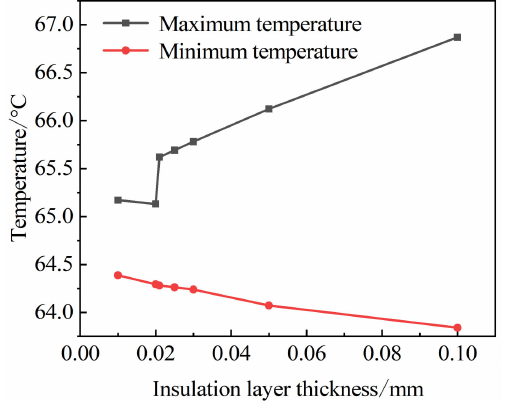
Figure 4. LED temperature under different insulation layer